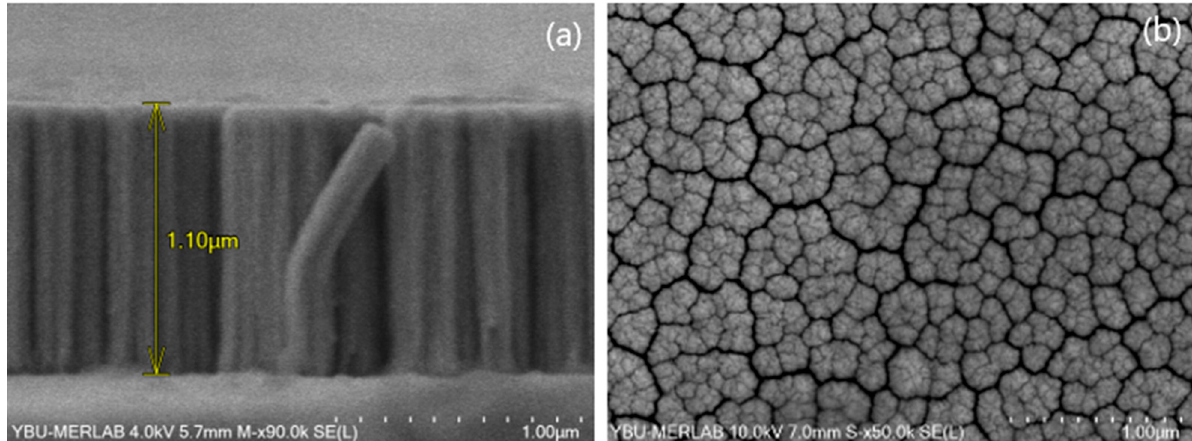
Figure 1. SEM photos of the nickel catalyst ( a ) cross-section, ( b ) planar.